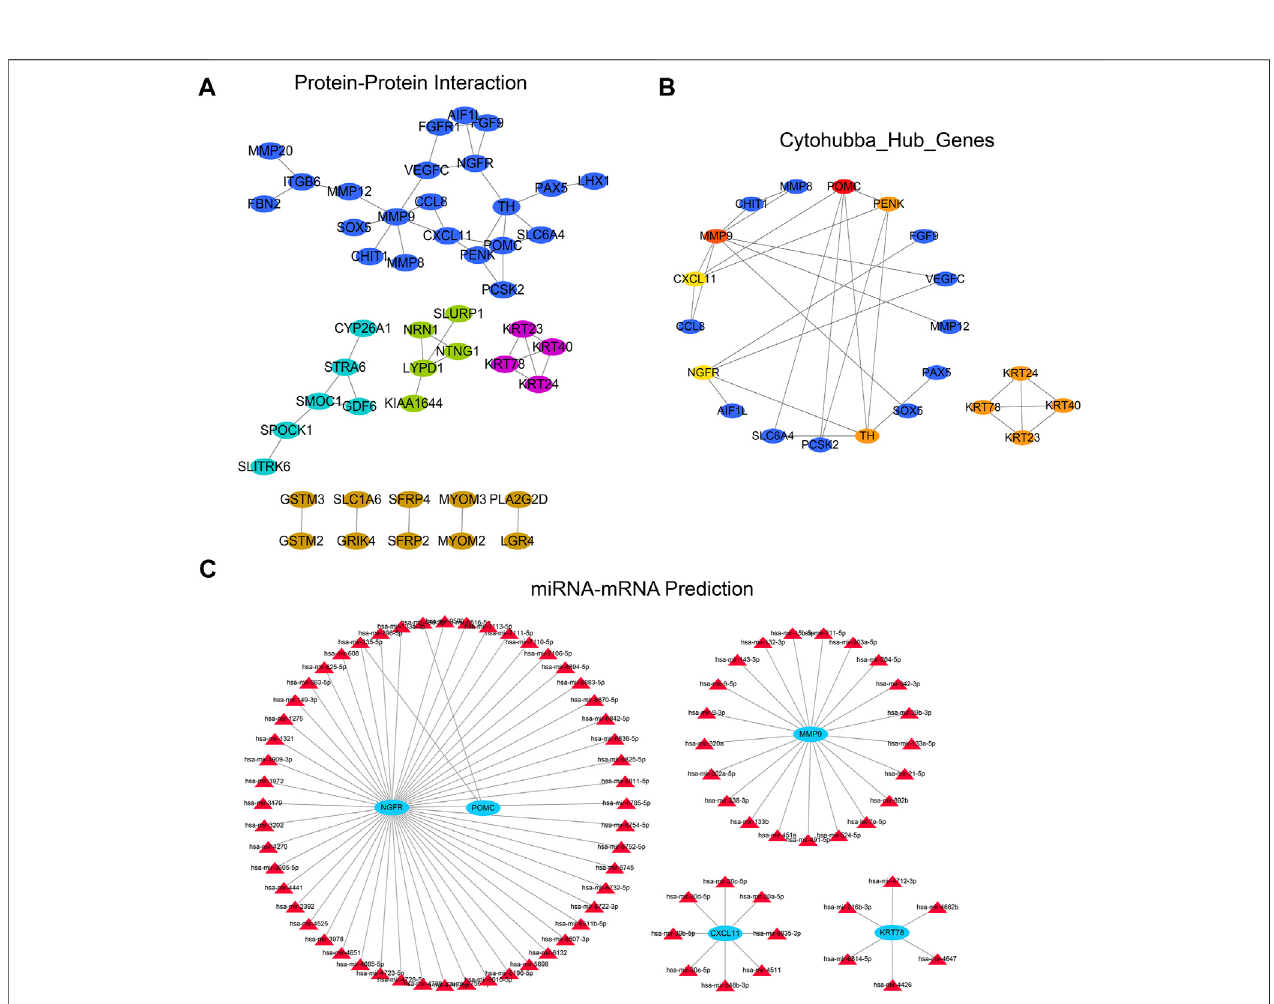
FIGURE8| PPIandmiRNAregulatorynetworkanalysisofdifferentialgenes. (A) PPIregulatorynetworkestablishedbydifferentialgenes; (B) Twosubnetworksand 10 hub genes were further screened by Cytohubba plug-in; (C) According to the miRNA-hub gene regulatory network predicted by the Networkanalyst database to regulate hub genes. The Networkanalyst database predicted the miRNA-hub gene regulatory network of regulatory hub genes.PPI, protein-protein